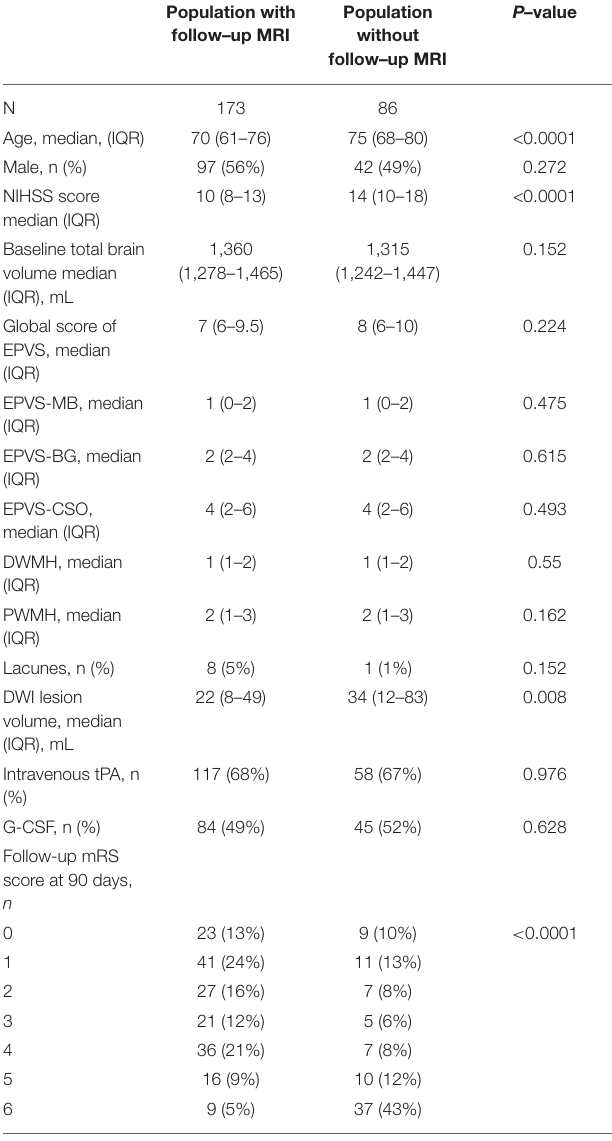
TABLE 1 | Comparison of baseline characteristics of patients with and without follow-up MRI.